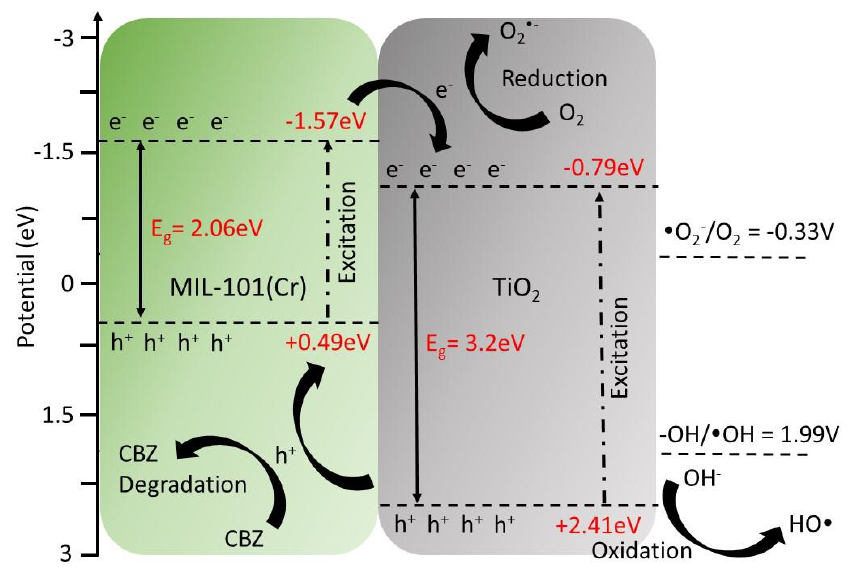
Figure 7. Proposed degradation mechanism using the UV − A/MIL − 101(Cr)@TiO 2 system.